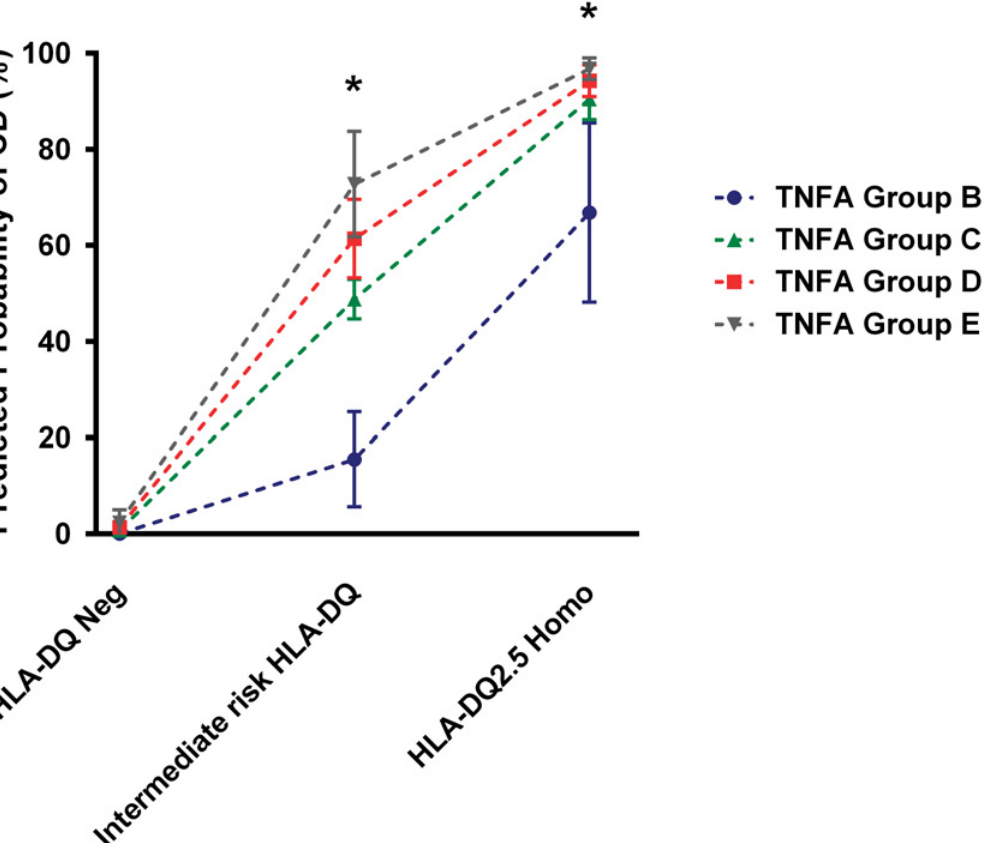
Fig 1. HLA-DQ and TNFA haplotype combinations predict CD risk. The marginal probability of CD was estimated on the basis of the multivariate binary logistic regression model reported in Table 4 adjusted for age, gender and H . pylori infection. Reference was the group of patients with negative HLA-DQ and TNFA group A haplotype combination. Dots and bars represent the estimated CD probability with their respective Bonferroni ’ s adjusted standard errors. * : p < 0.05 for all groups with respect to TNFA Group A and p < 0.05 for TNFA Group D with respect to TNFA Group B (pairwise comparisons of marginal linear